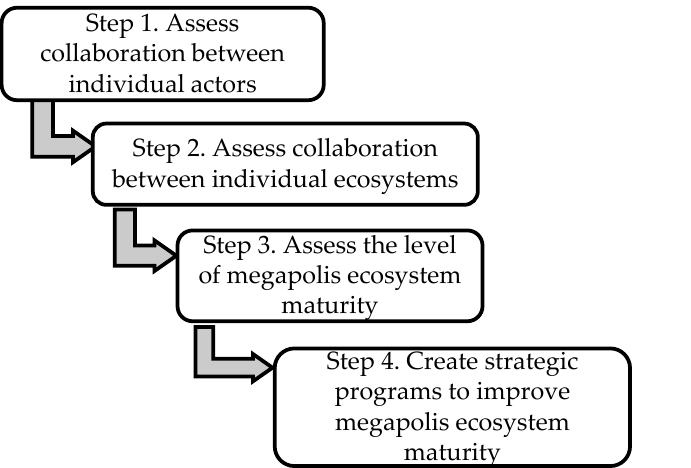
Figure 3. Methodological framework for assessing ecosystem collaboration. Source: Own elabora- tion.